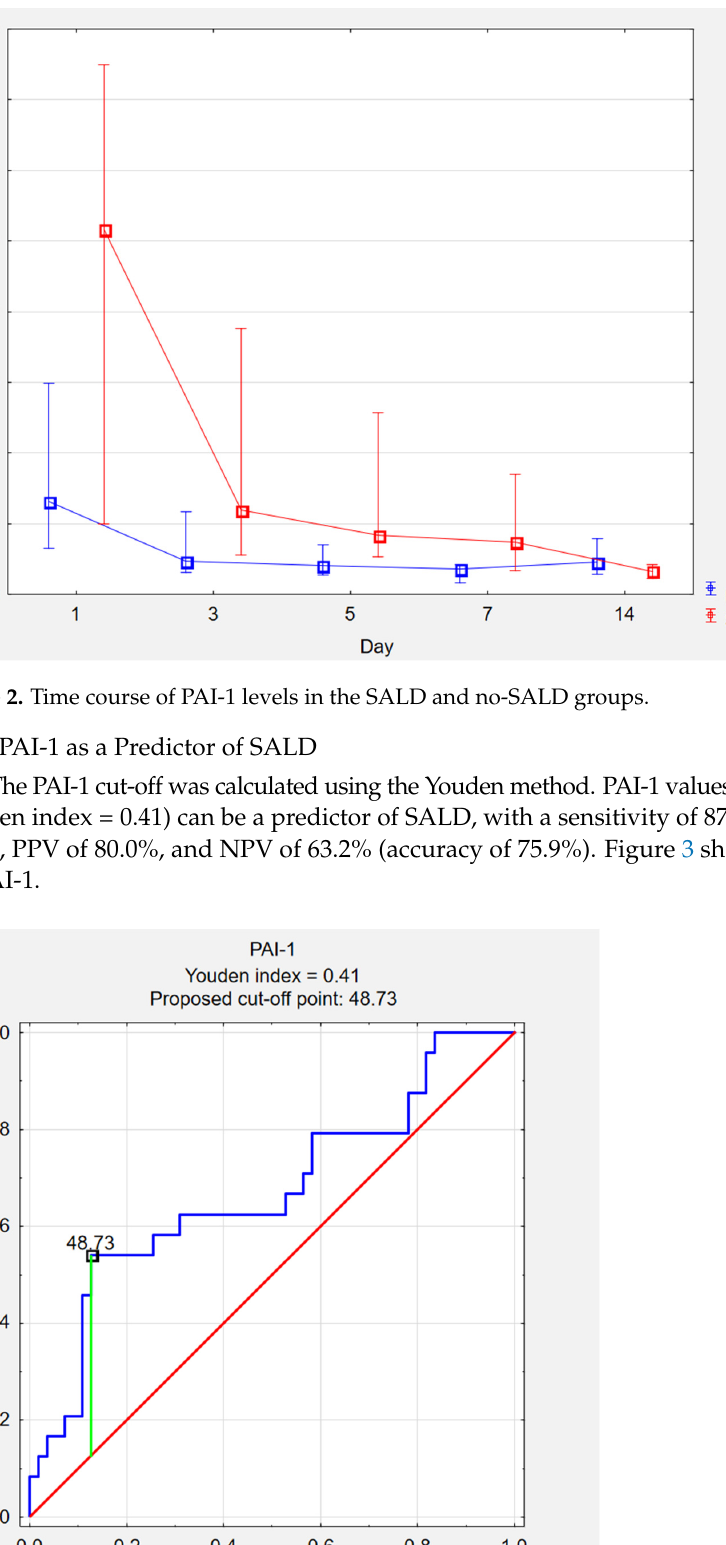
( b ) Figure 4. Kaplan–Meier survival curves for: ( a ) bilirubin—comparison between the SALD and no- SALD groups; ( b ) PAI-1. Univariate and multivariate Cox proportional hazard regression models were used to investigate factors associated with mortality. Variables with p < 0.30 in the univariate analysis were entered into the multivariate model. Variables that were found to be signif- icant ( p < 0.05) in both the univariate and multivariate analyses were considered to be factors associated with mortality (Table 6). A multivariate analysis has shown that among analysed biomarkers (Age, PAI-1, APACHE II, SOFA, and Lactate (mmol/L), CRP (mg/L), PCT (ng/mL), BIL (mg/dL), AST